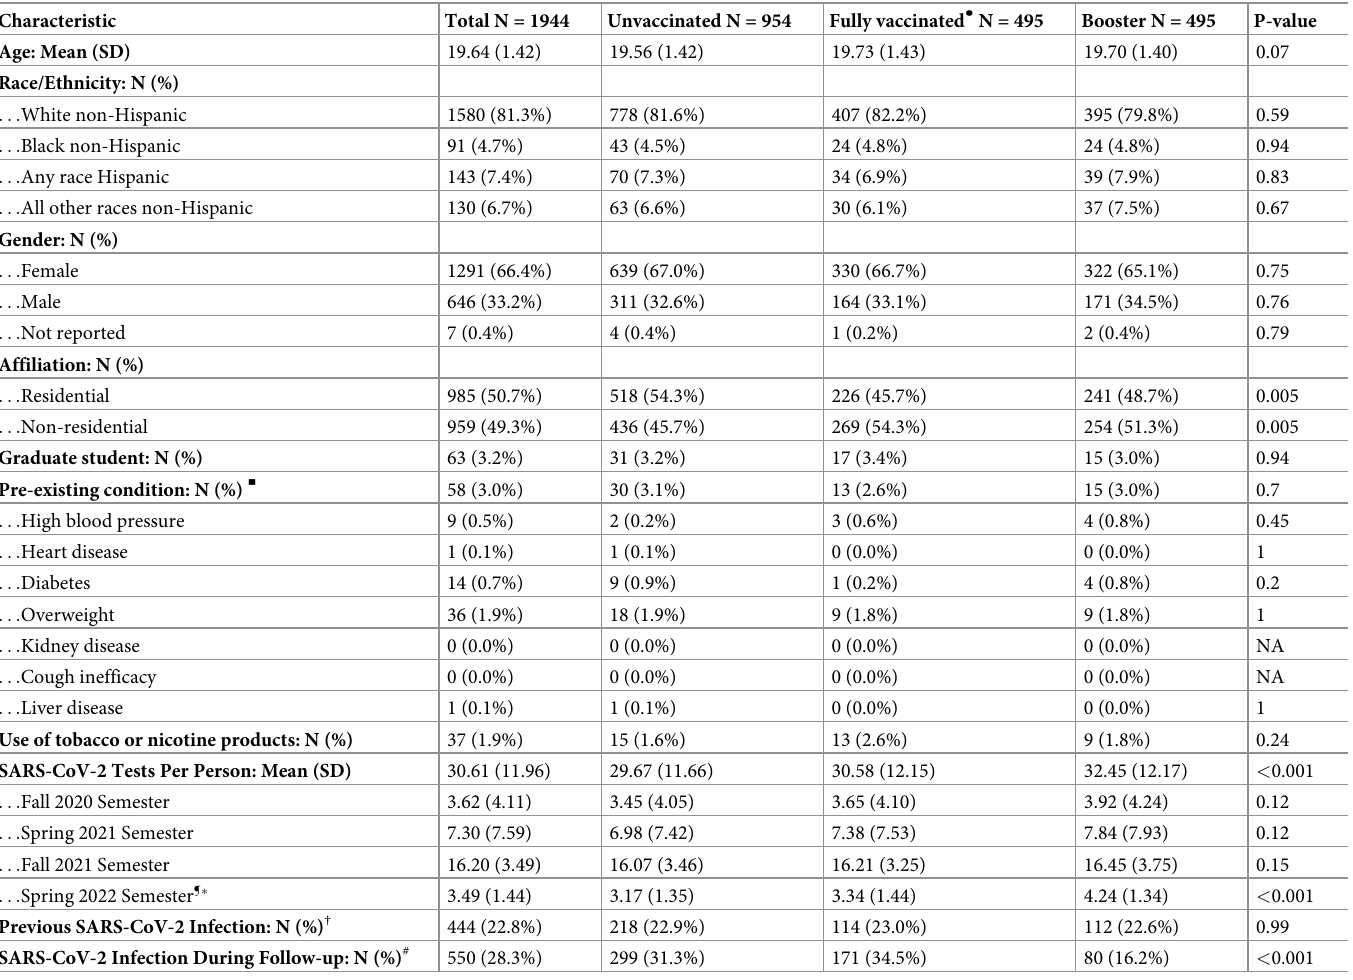
Table 1. Descriptive characteristics for students in the analytic sample after propensity score